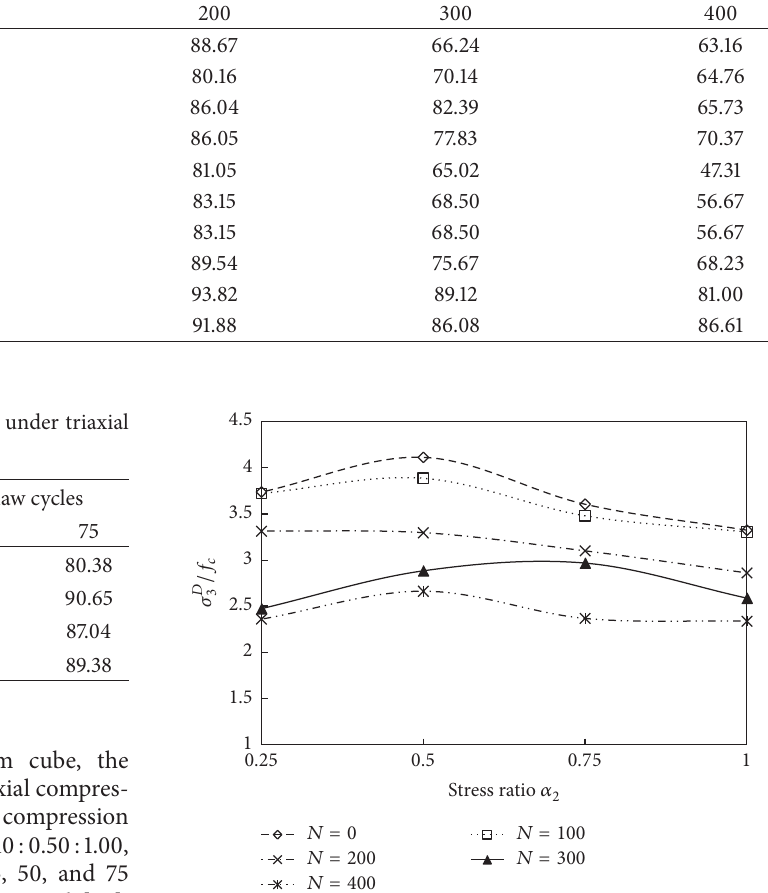
Table 3: Loss of ultimate strength of air-entrained concrete under triaxial compression load with rapid freeze-thaw cycles (%). Stress ratio